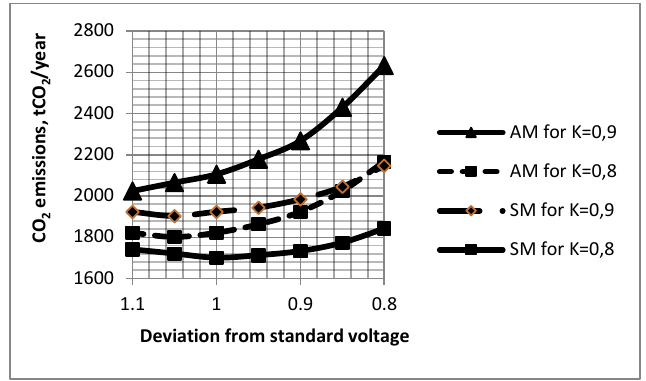
Fig. 5. Reduction of GHG emissions form asynchronous (AM) and synchronous (SM) motors. Similar impact on climate change results from the use of GHG emissions is larger in cases when an asynchronous motor is